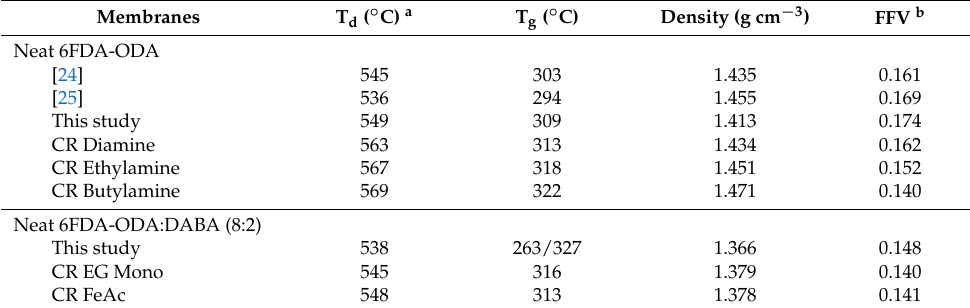
Table 1. Physical properties of neat 6FDA-ODA, neat 6FDA-ODA:DABA (8:2) and their respective crosslinked membranes. FFV is calculated from the reciprocal density values, measured at 20 ◦ C with pressurized He cycles between 2 and 20